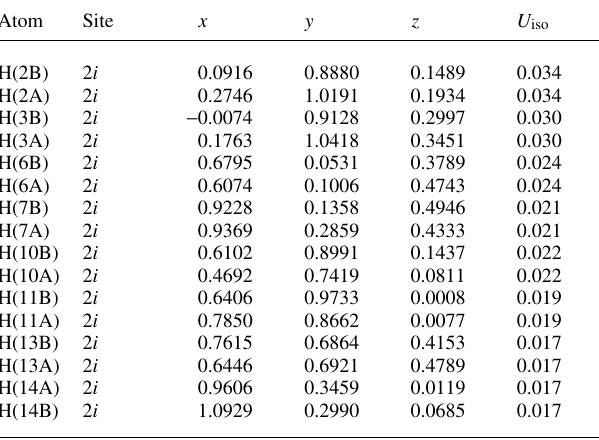
Table 2. Atomic coordinates and displacement parameters (in Å 2 )